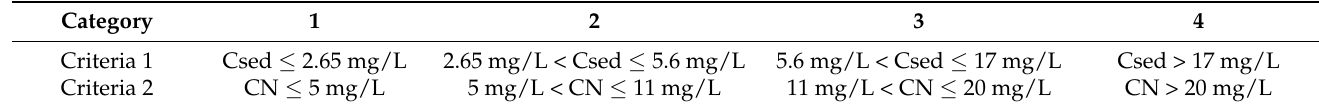
Table 1. Criteria for classification of regulatory requirements for the treatment of drinking water by country (Csed: Concentration of total suspended solids, CN: Concentration of